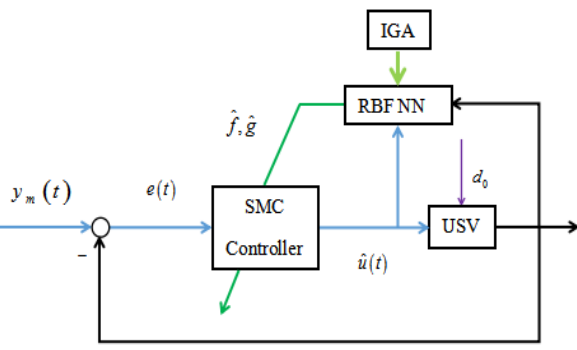
Figure 3. The intelligent control algorithm flow of the unmanned surface vehicle (USV).